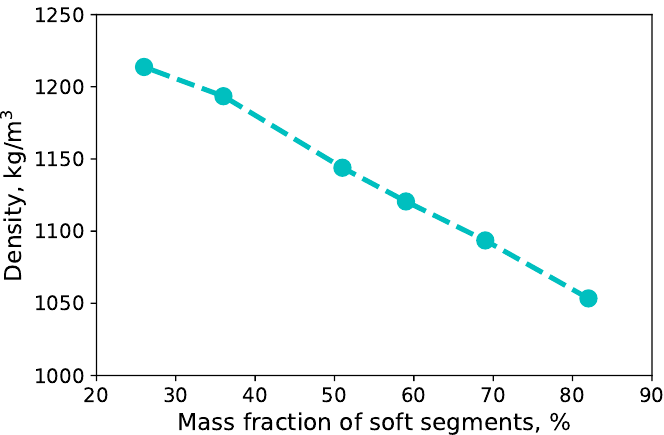
Figure 7. Density of TPU as function of mass fraction of soft segments at normal conditions.